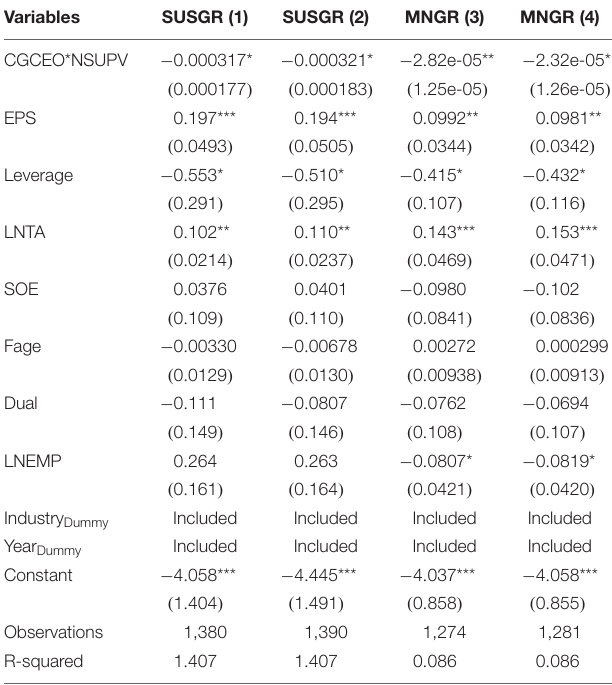
TABLE 5 | 2SLS regression for number of supervisors and sustainable